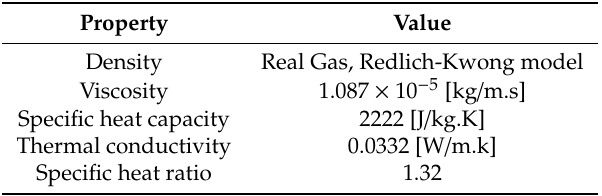
Table 6. Properties of carrier